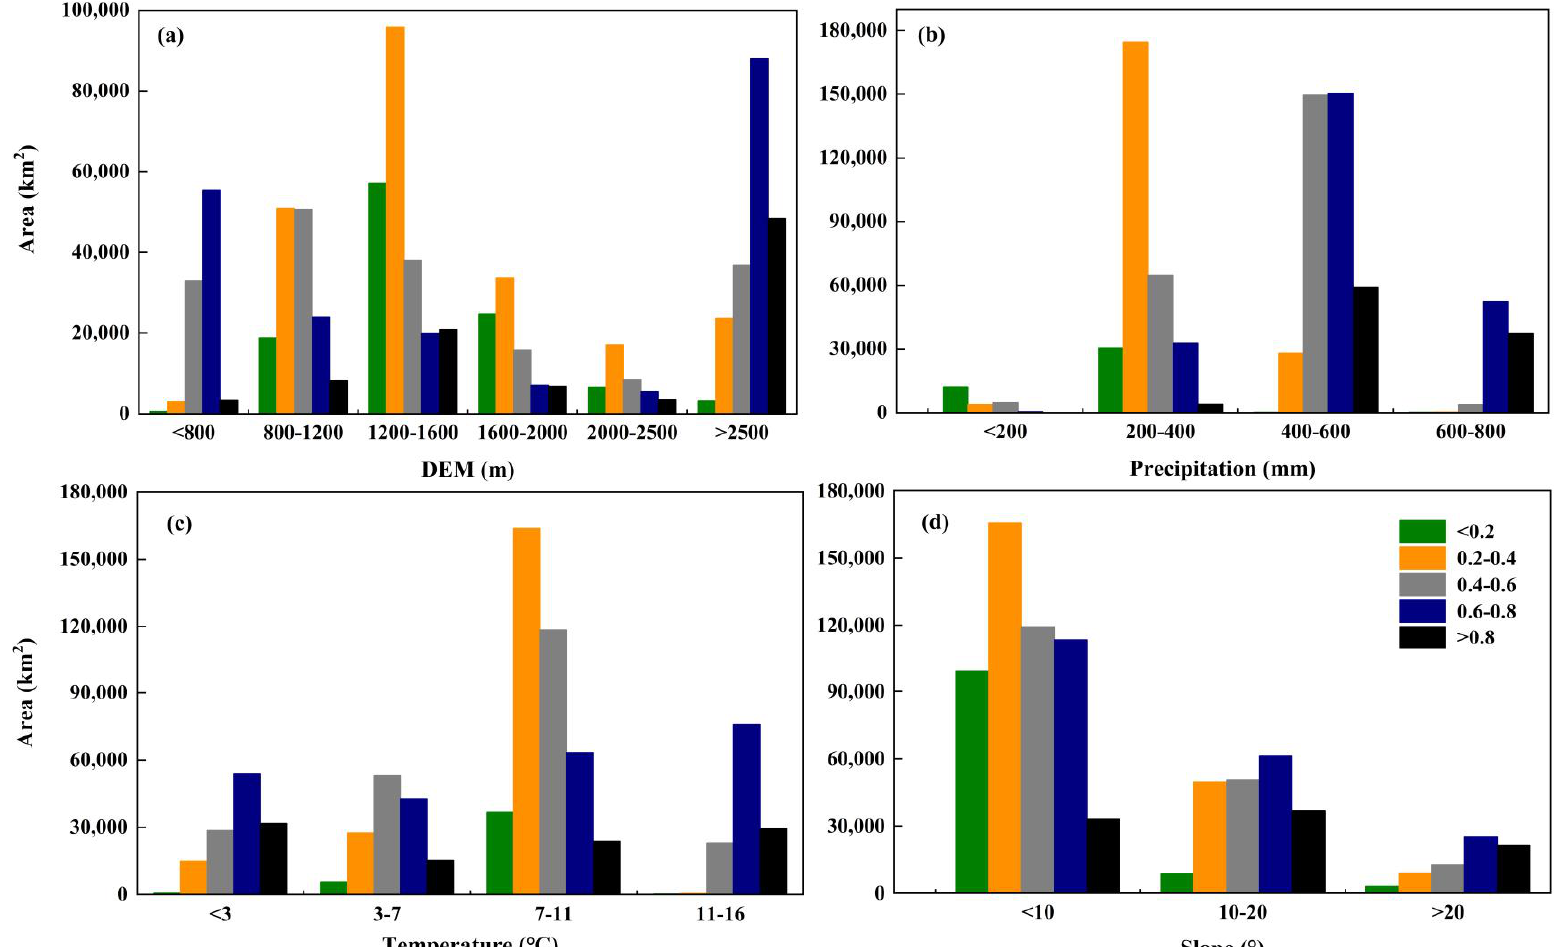
Figure 3. Distribution of different levels of the normal difference vegetation index (NDVI) under different types of topographic and climatic factors. ( a ) Elevations (m), ( b ) precipitation (mm), ( c ) temperature ( ℃ ), and ( d ) slope (°). In the legend, <0.2, 0.2 – 0.4, 0.4 – 0.6, 0.6 – 0.8, and >0.8 represent NDVI levels L 1 , L 2 , L 3 , L 4 , and L 5 , respectively.